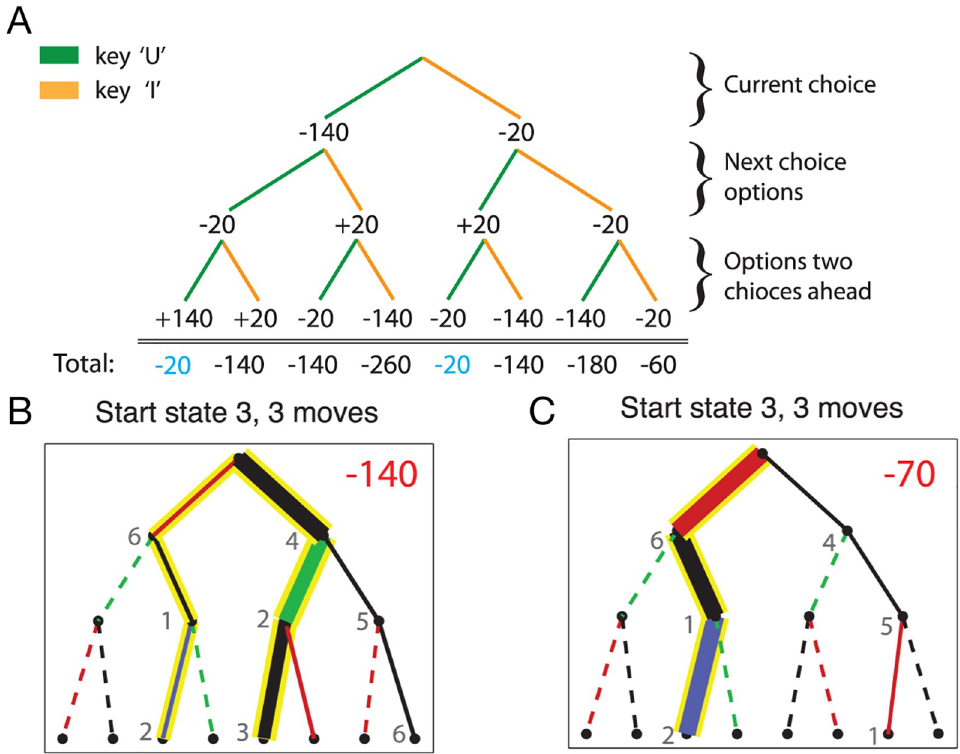
Fig 3. Example search trees from [12]. A : Starting at state 3, subjects make three consecutive decisions (pressing ‘U’ or ‘I’), each of which are associated with a gain or loss. Two trajectories maximize the cumulative rewards in this example and achieve − 20. B and C : State transition frequencies of subjects. Higher frequencies are illustrated with thicker lines. If a transition is not taken by any of the subjects, then it is illustrated with a dashed line. Yellow backgrounds show the optimal trajectories. Colors red, black, green, and blue denote the transition rewards of P , − 20, + 20 and + 140 respectively. B : P = − 140 condition. It can be seen that the subjects avoid the action associated with the large punishment. C : P = − 70 condition. Subjects are eager to take transitions with large losses when such transitions lead to large gains (i.e., + 140), which in fact is the optimal strategy. Reprinted with permission from [12].